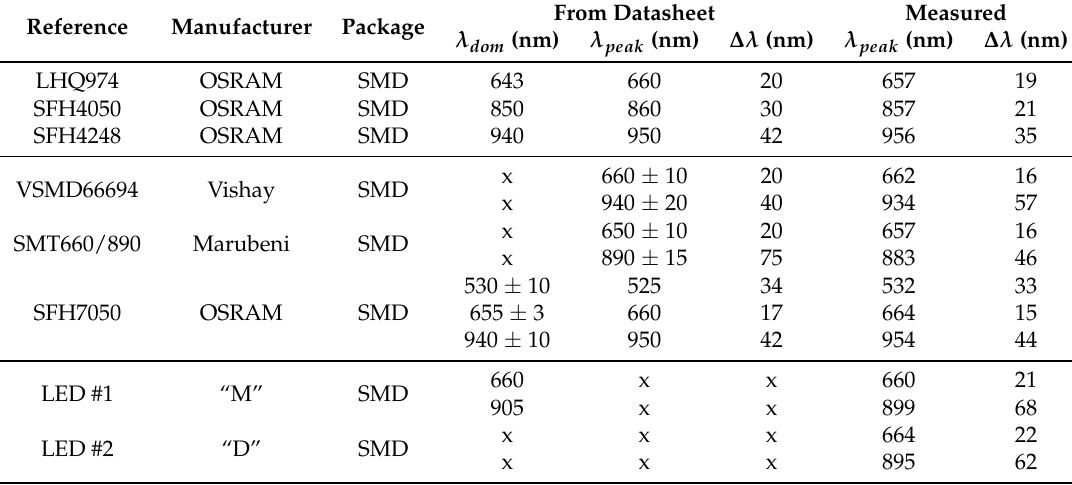
Table 1. Selected suitable LEDs for pulse oximetry. All LEDs were tested at room temperature (25 ◦ C), under the same conditions mentioned in their respective datasheet to compare the spectral measurements (i.e., if the forward current specified was 20 mA, we set our current source in the setup as If = 20 mA) [39–48]. Values marked “x” were not reported in the corresponding